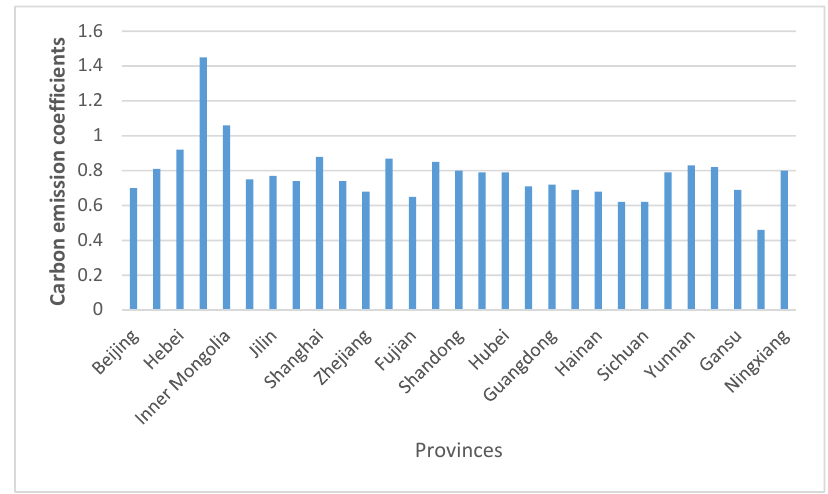
Figure 1. Carbon emission factors of provinces in China.